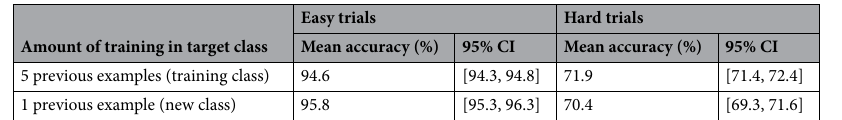
Table 2. Results from human participants. Mean accuracy and 95% confidence intervals are reported across all trial types, calculated using a non-parametric bootstrapping approach. Human performance does not differ with the number of training images to which the participant is exposed. As expected, accuracy on hard trials is lower than accuracy on easy trials.